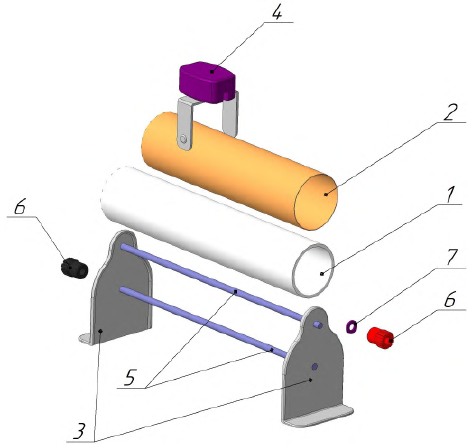
Figure 3: Electronic model of rheostat.